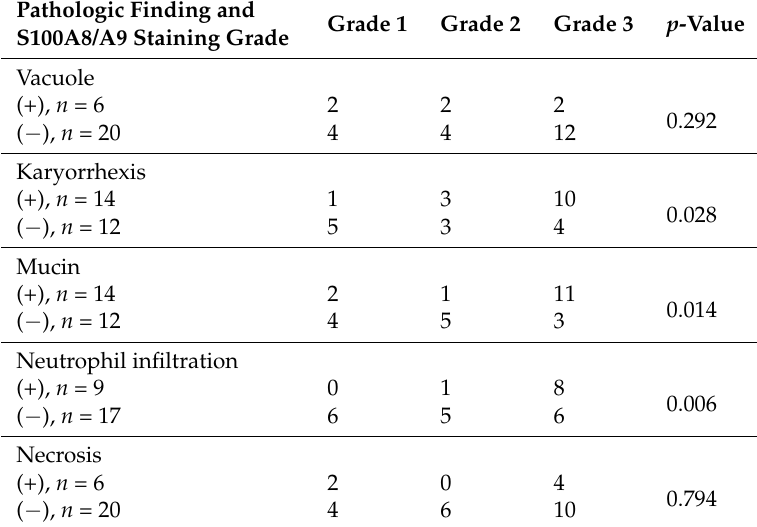
Table 3. The inflammatory cell staining for S100A8/A9 of skin in adult-onset Still’s disease. Pathologic Finding and S100A8/A9 Staining Grade